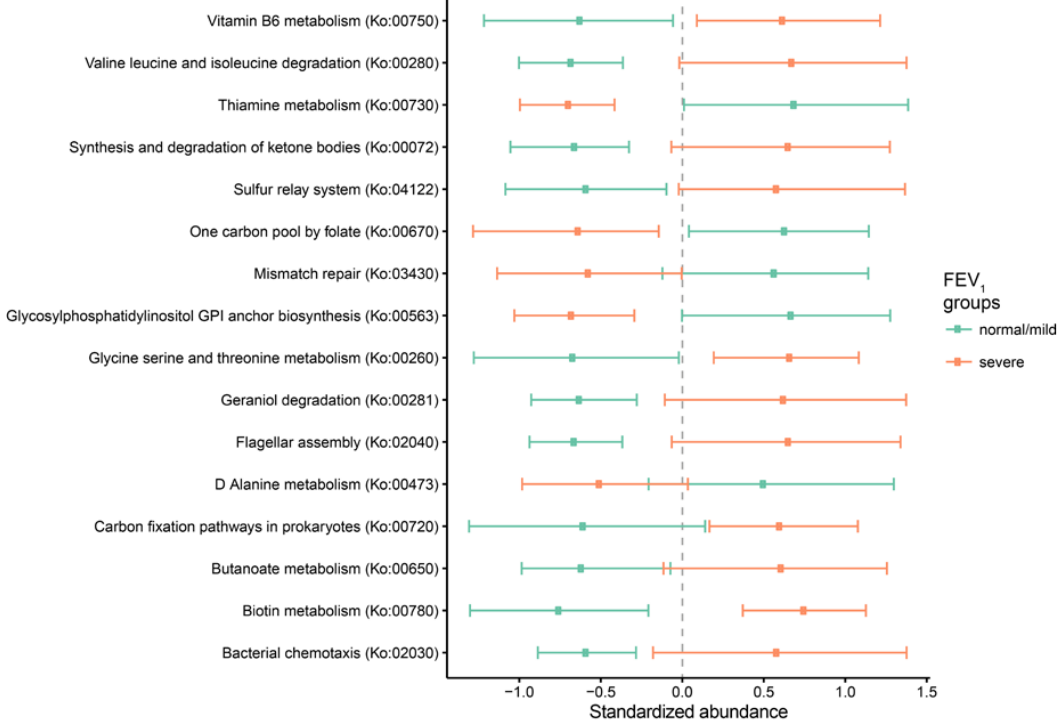
Figure 2. Differences in metabolic and regulatory pathways detected with HMP Unified Metabolic Analysis Network HUMAnN. Colors indicate statistically significant differences ( p -value < 0.05) after Kruskal–Wallis one-way analysis of variance. Values indicate mean and one standard deviation (bars). Standardized abundances (x axis) were calculated as: [x − m(x)]/sd(x), where “SD” is the standard deviation and “m” is the mean value.